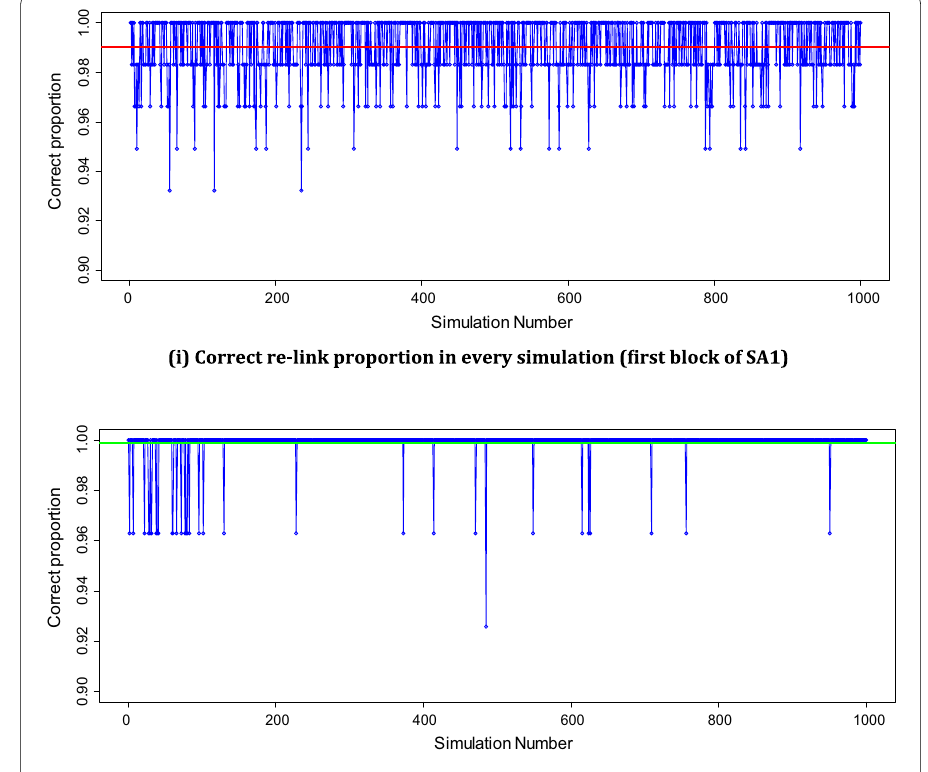
Fig. 7 Correct re-link proportion in every